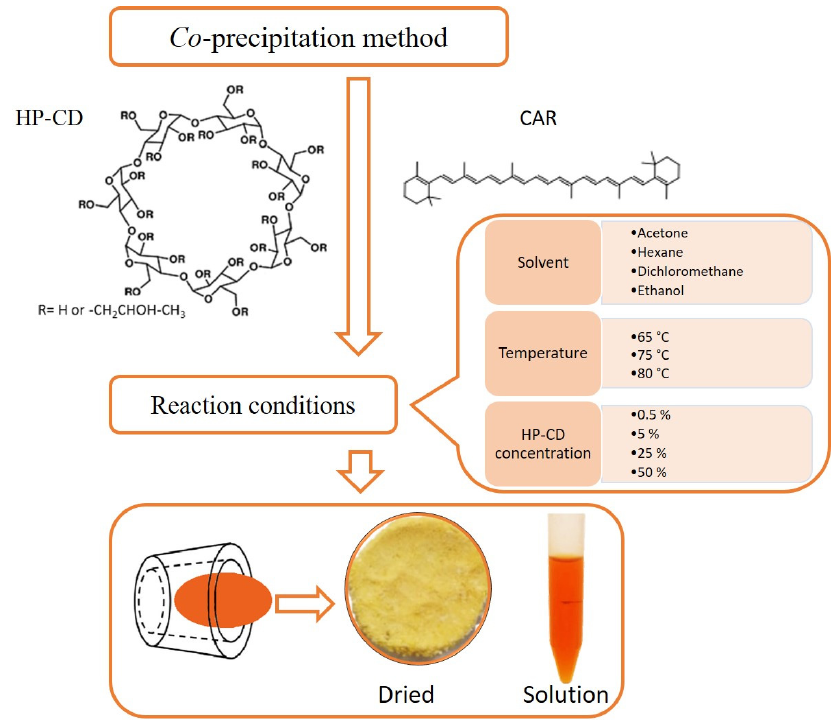
Figure 6. Schematic summary of the preparation of water ‐ dispersible β‐ carotene/2 ‐ hydroxypropyl ‐ β‐ cyclodextrin aggregates.